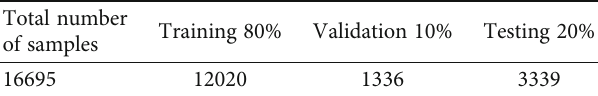
Table 2: Splitting of the used